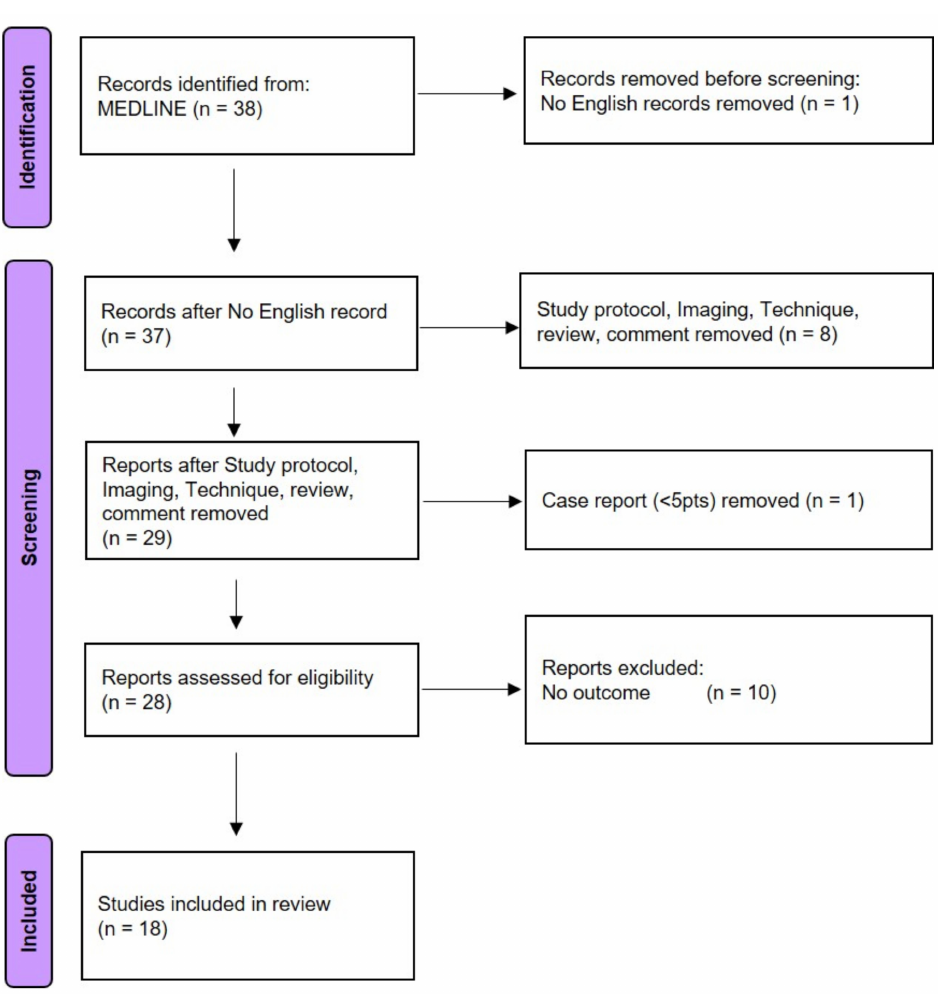
Figure 4. Preferred Reporting Items for Systematic Reviews and Meta-Analyses (PRISMA) used for literature